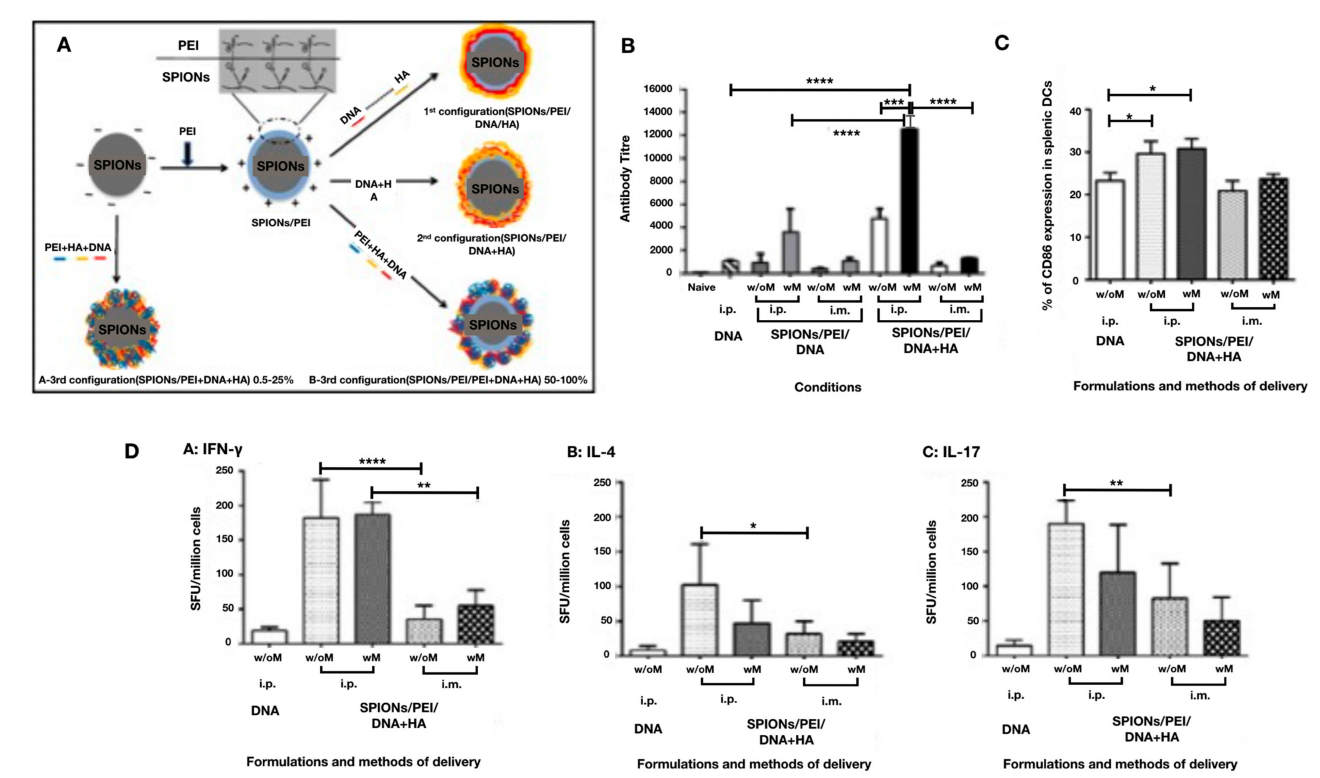
Figure 8. SPION based DNA vaccine delivery system enhanced using an external magnetic field. ( A ) Illustration of superparamagnetic iron oxide nanoparticles (SPIONs) functionalization with polyethylenimine (PEI), and hyaluronic acid (HA) in di ff erent synthesis sequences for use as carriers for malaria DNA vaccine encoding Plasmodium yoelii merozoite surface protein MSP1-19 (VR1020-PyMSP1-19). Reprinted with permission [110]. ( B ) Results of Elisa assay demonstrating the induction of antibody responses by SPIONs / PEI / DNA + HA, SPIONs / PEI / DNA, or naked DNA, through di ff erent routes of administration, either intraperitoneal (i.p.) or intramuscular (i.m.). ( C ) Activation of dendritic cells in the spleen post injection with SPIONs / PEI / DNA + HA complexes via i.p. or i.m. administration (naked DNA via i.p. only), with or without the application of a magnetic field. ( D ) Results of ELISpot assays demonstrating antigen-specific T cell responses induced by the SPIONs / PEI / DNA + HA complexes in vivo. Data expressed as antibody titer mean ± SD of 2 individual experiments. Statistical significance was designated as * p ≤ 0.05, ** p < 0.01, *** p < 0.001, **** p < 0.0001, ((w / M) with magnet, (wo / M) without magnet). Reprinted from [106], which is an Open Access article